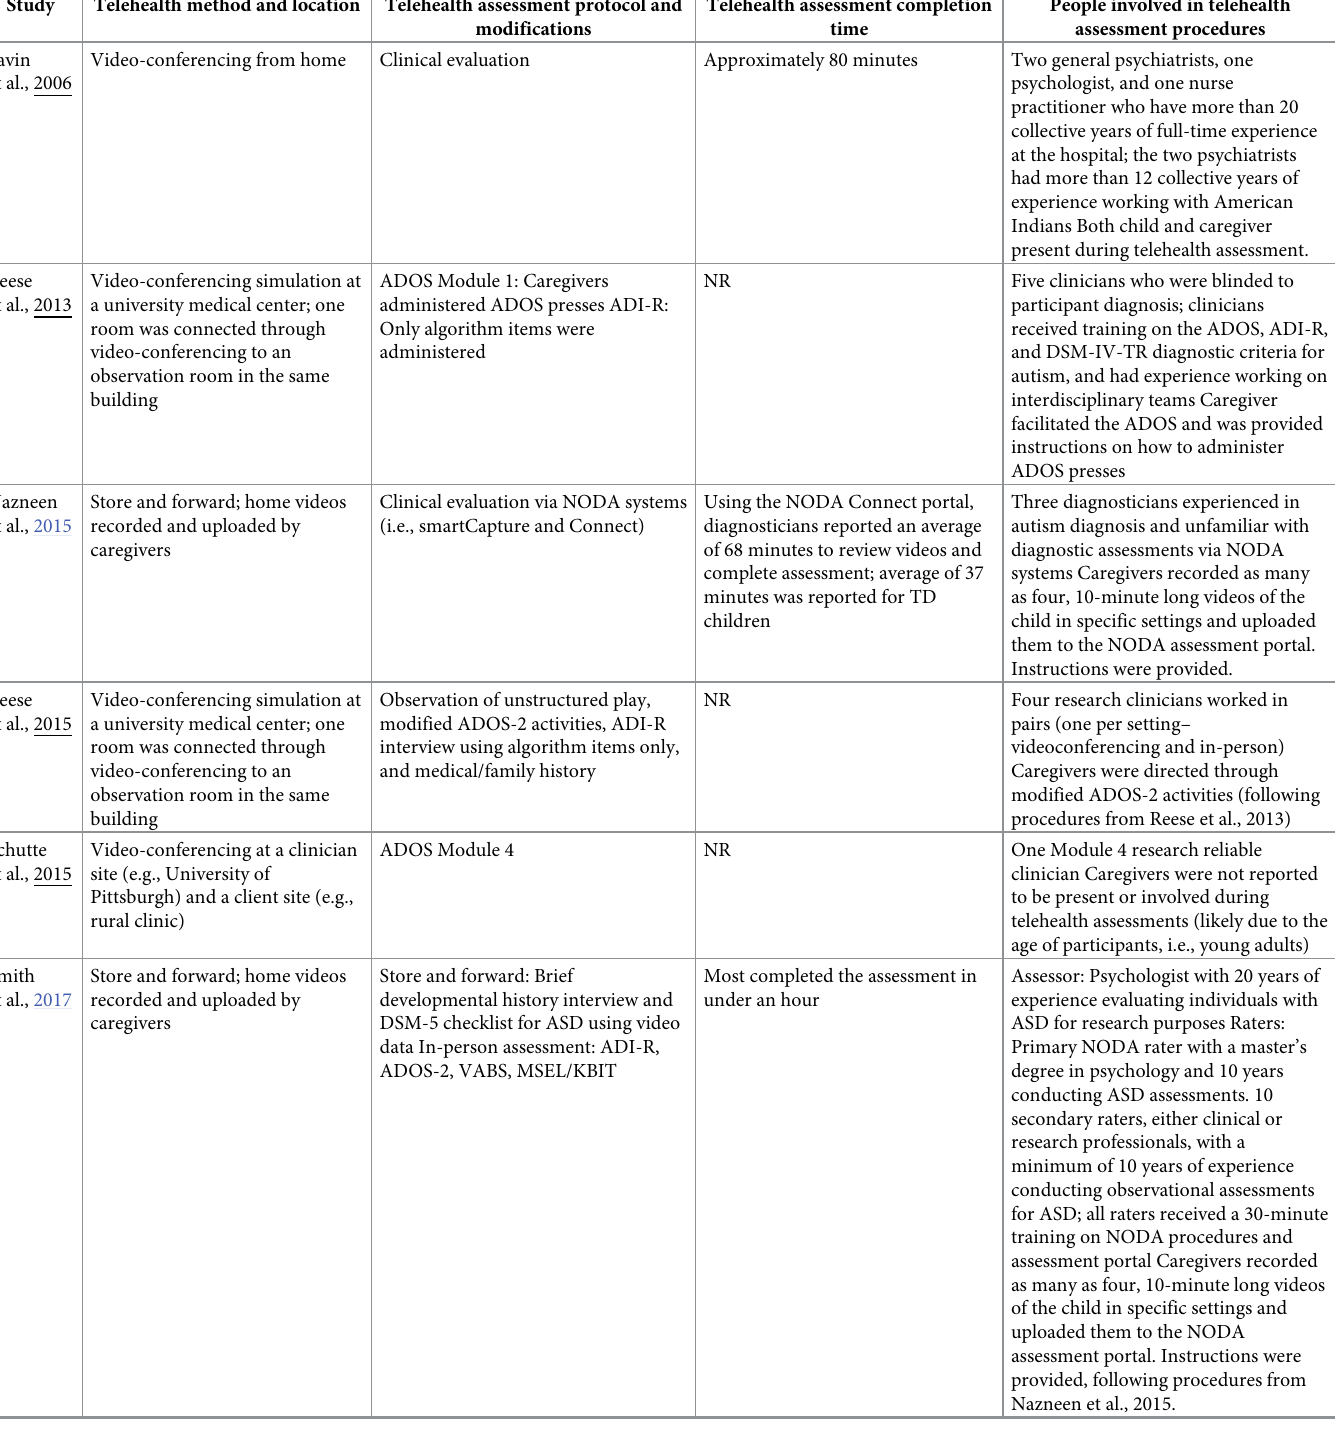
Table 3. Telehealth assessment information and procedures from included